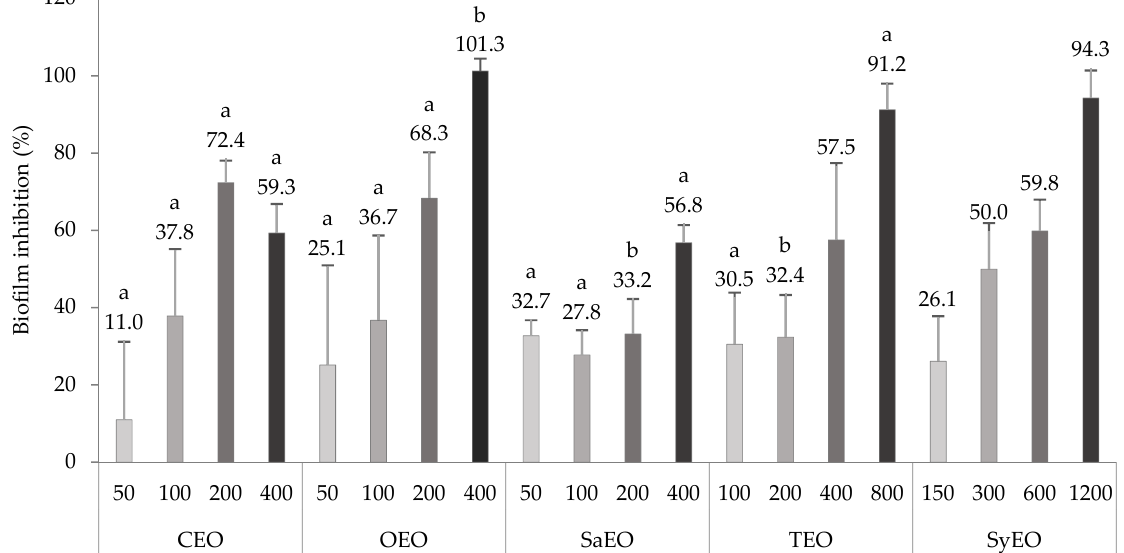
Figure 2. Evaluation of the antibiofilm activity of essential oils on the biofilm of Salmonella sv. Typhimurium formed in microplates. EOs are tested at concentrations greater than or equal to those applied to Caenorhabditis elegans during the colonization assay. Inhibition scores in percentage are means ± SD ( n = 9). EOs at the same concentration with different letters are statistically different ( p <